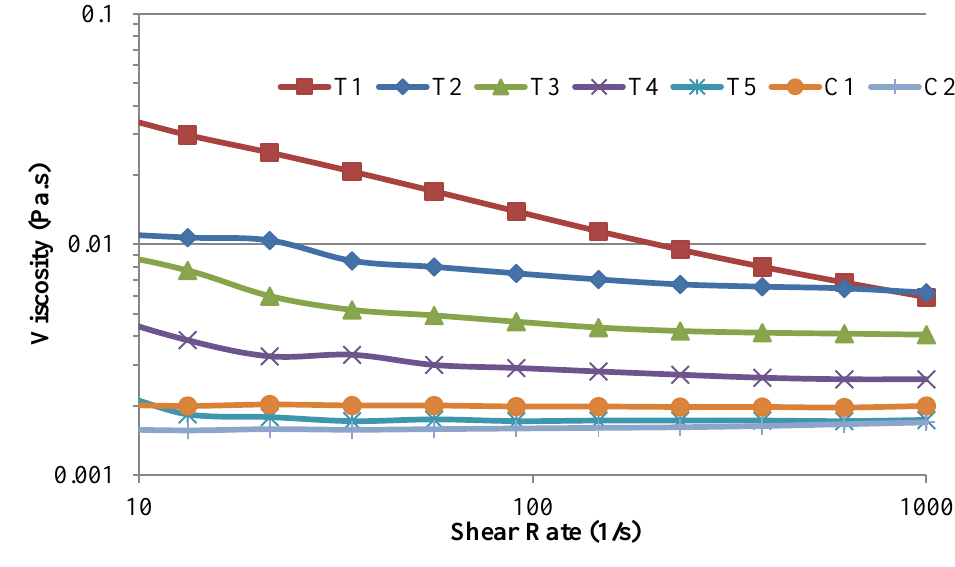
Figure 2. Viscosity of experimental